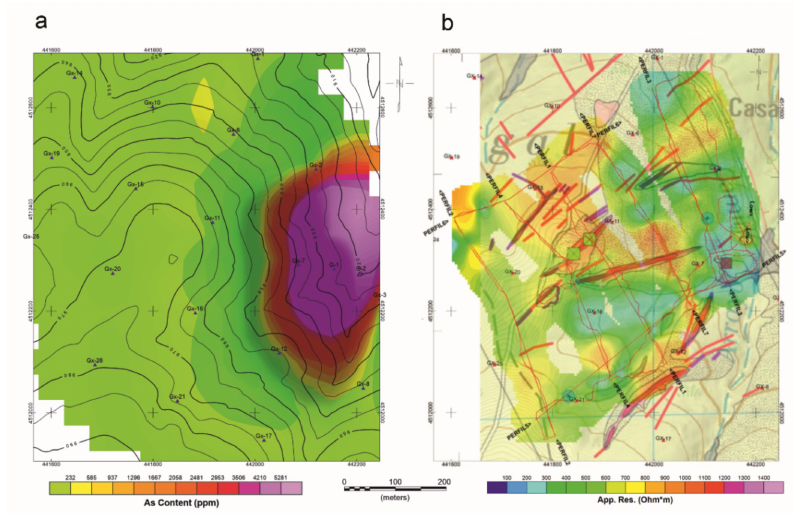
Figure 11. ( a ) Geochemical and ( b ) Geophysical